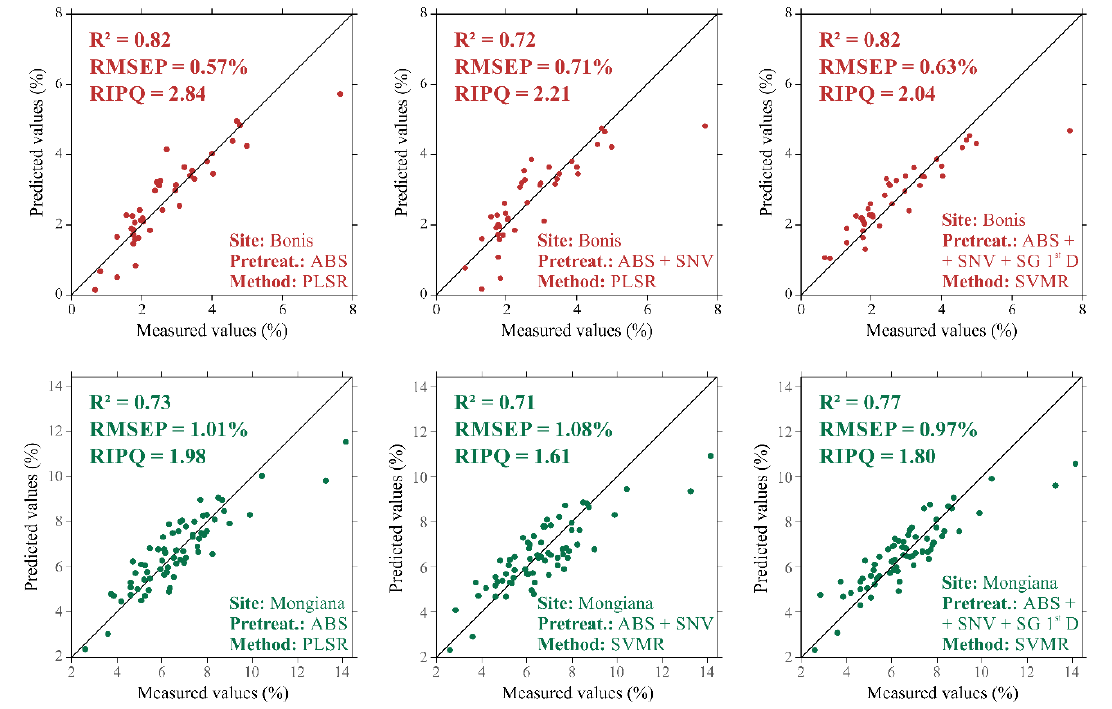
Figure 3. Scatter plots of the best performances of the SOC prediction models obtained by PLSR, and SVMR coupled with each of the three different spectroscopic pretreatment techniques. Above and in red are shown the results for the Bonis catchment area, and below and in green those for the Mongiana area. ABS = Absorbance; SNV = Standard Normal Variate; SG 1st D = Savitzky–Golay 1st order derivative.